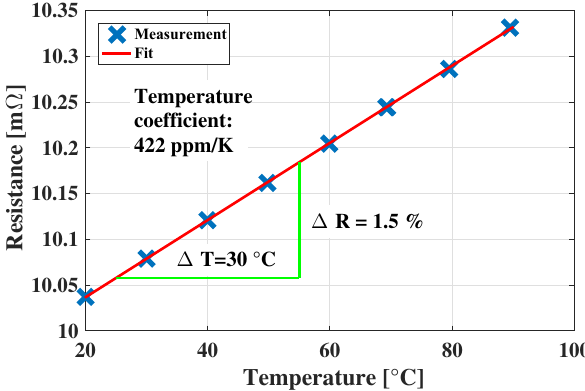
Figure 2. Measured temperature dependence of a single 10m (cid:127) shunt resistor, approximated by a linear fit. The total resistance change for a temperature increase of (cid:49)T = 30 ◦ C is highlighted (Grundkötter,